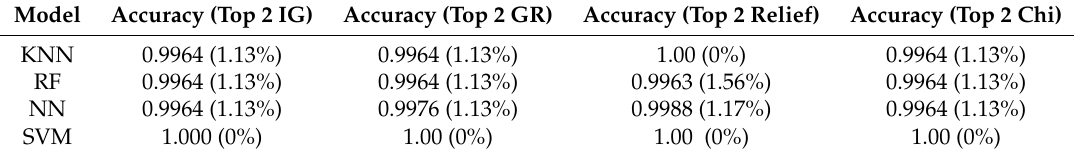
Table 3. Classification average accuracy and standard deviation of 10 folds for KNN, NN, RF, and SVM classifiers using first and second important features of IG, GR, Relief, and chi-squared algorithms.